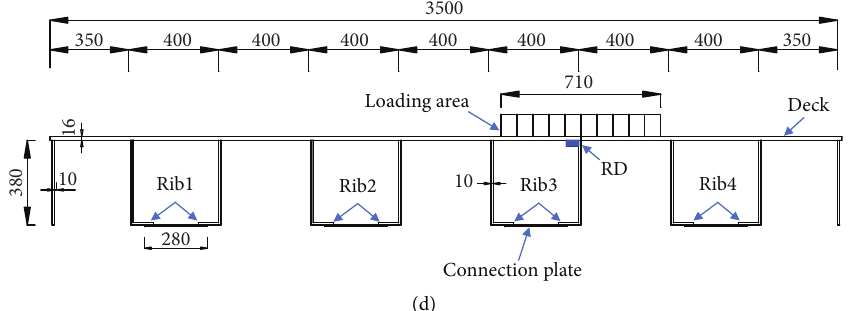
Figure 5: Wheel load position of fatigue test (unit: mm). (a) Elevations of model. (b) Upward view of model. (c) 1–1 Sectional view. (d) 2–2 Sectional view.